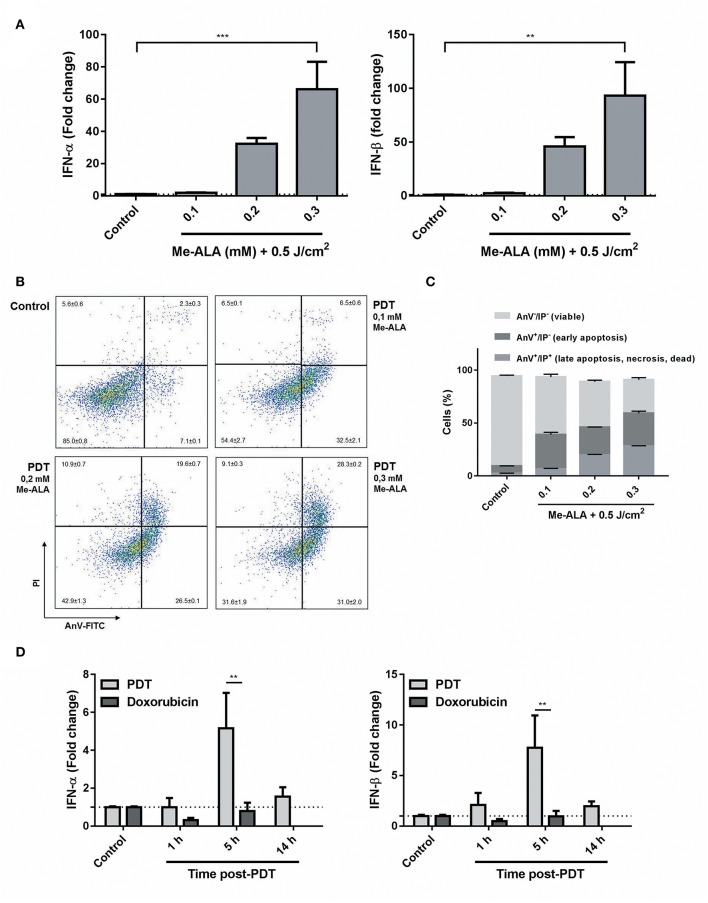
Photodynamic therapy as a novel inductor of IFN-1 expression on melanoma cells. (A) B16-OVA cells were incubated with Me-ALA (0.1, 0.2, and 0.3 mM) for 4 h and then were irradiated with visible light (0.5 J/cm2). Quantification of mRNA expression of IFN-1α (right) and IFN-β (left) was performed 5 h after treatment by RTqPCR and normalized with respect to the non-treated control (dotted line: 1). Data are mean ± SEM of three independent experiments. **p < 0.01, ***p < 0.05 vs. control group (untreated cells), One-Way ANOVA Bonferroni post-test. (B) Type of cell death was evaluated using Annexin V/PI staining by flow cytometry. The data generated by flow cytometry were plotted in two-dimensional dot plots in which PI is represented vs. Annexin V-FICT. (C) Viable cells (Annexin V−/PI−), undergoing (early) apoptotic cells (Annexin V+/PI−) and dead, necrotic or late (end-stage) apoptotic cells (Annexin V+/PI+) were quantified using FlowJo 10.0.7 software. (D) B16-OVA cells were subjected to high dose PDT (Me-ALA 0.3 mM + 0.5 J/cm2) or doxorubicin (30 μM). Quantification of mRNA expression of IFN-1-α (right) and IFN-β (left) was performed 1, 5, and 14 h after treatment by RTqPCR and normalized with respect to the non-treated control (dotted line: 1). Data are mean ± SEM of three independent experiments. **p < 0.01 vs. PDT group (gray bars), Two-Way ANOVA Bonferroni post-test.